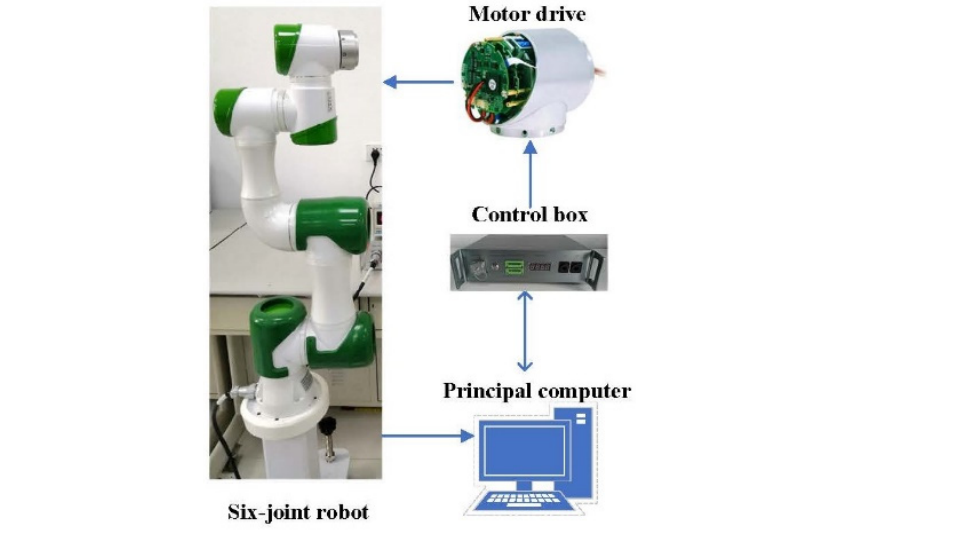
Figure 11. The schematic of the autonomous experimental platform.